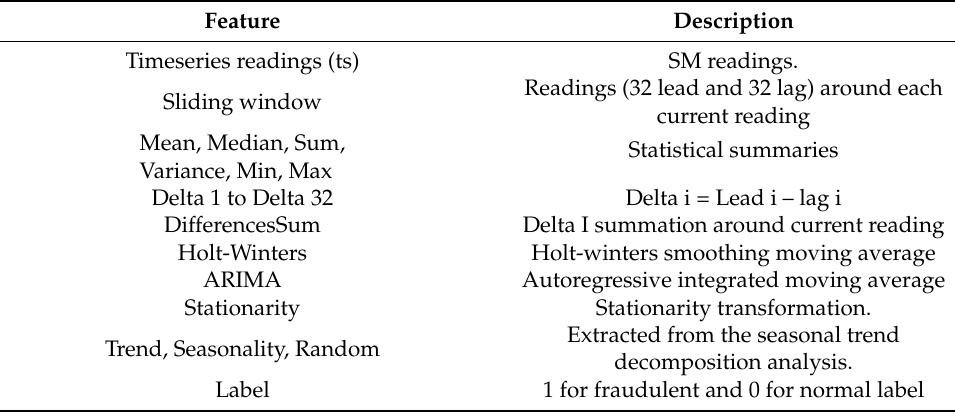
Table 1. Fraudulent detection engineered feature-set. Feature